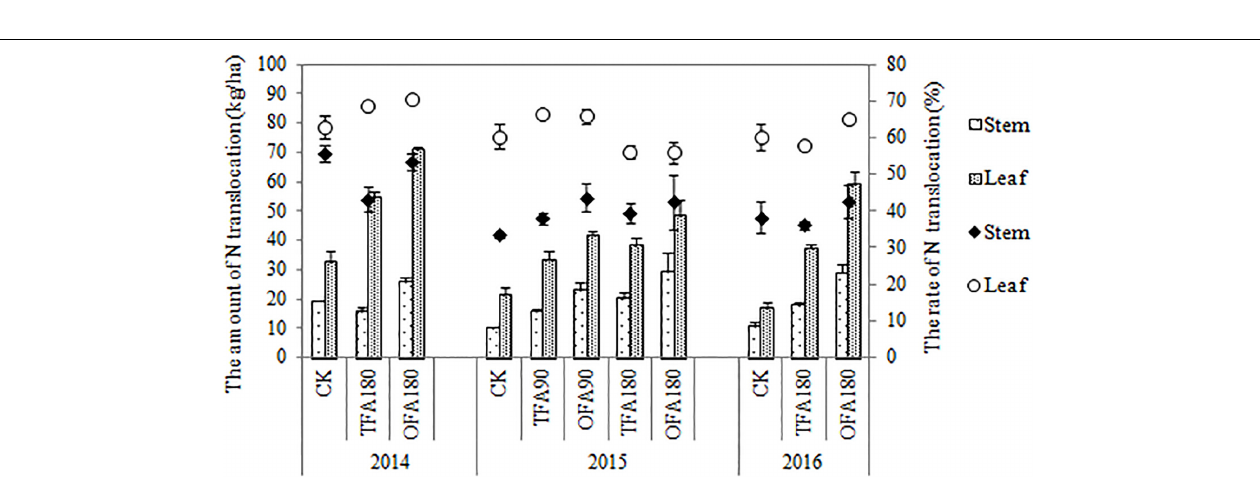
FIGURE 3 | Nitrogen distribution and source accumulated in panicle. CK: No nitrogen applied, TFA: traditional nitrogen fertilizer application, OFA: optimized nitrogen fertilizer application, 90: total nitrogen application rate of 90 kg ha − 1 ; 180: total nitrogen application rate of 180 kg ha − 1 . Data represent mean values of three biological replicates.